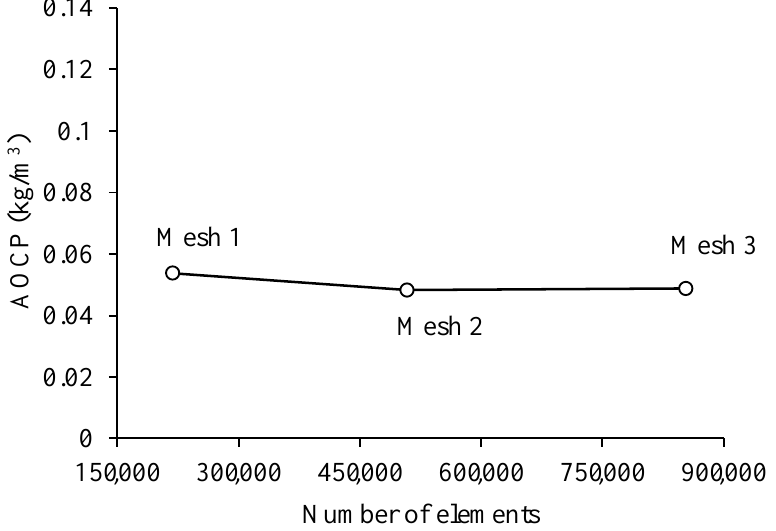
Figure 3. Average oil concentration in the permeate outlets for the three meshes used in the research (Cases 1, 2, and 3).